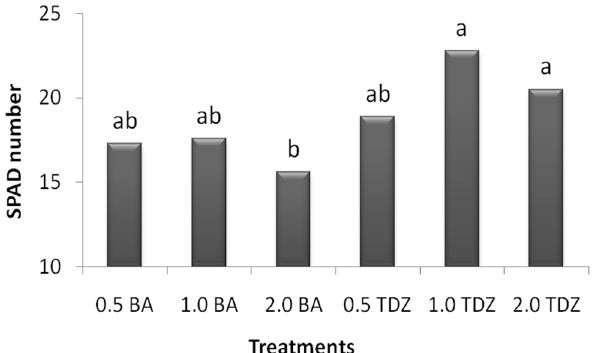
Fig. 2. Effect of different BA and TDZ levels on the SPAD num- ber (all treatments also contained 0.2 mg/l NAA). Means with the same letters are not significantly different based on